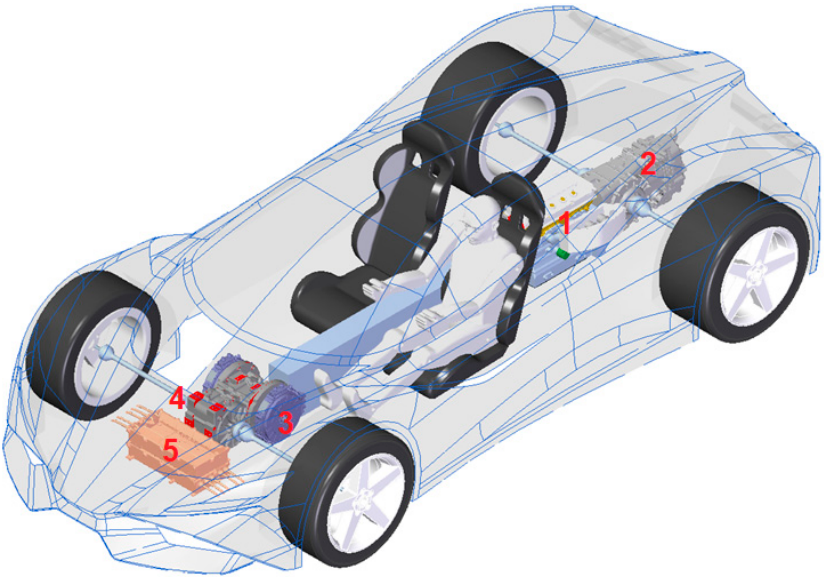
Figure 3. Powertrain architecture: 1, i.ci engine; 2, rear gearbox; 3, Yasa motors; 4, front transmission; 5, inverters.